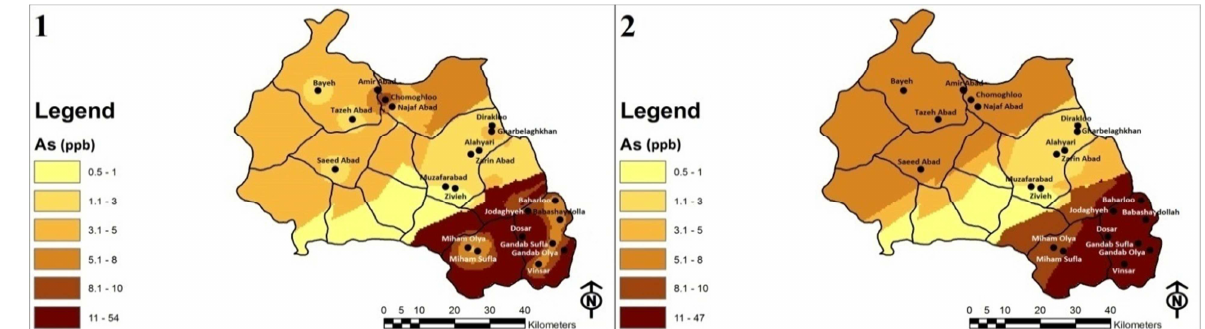
Figure 2. Spatial distribution of arsenic in ground water in low- and high-water